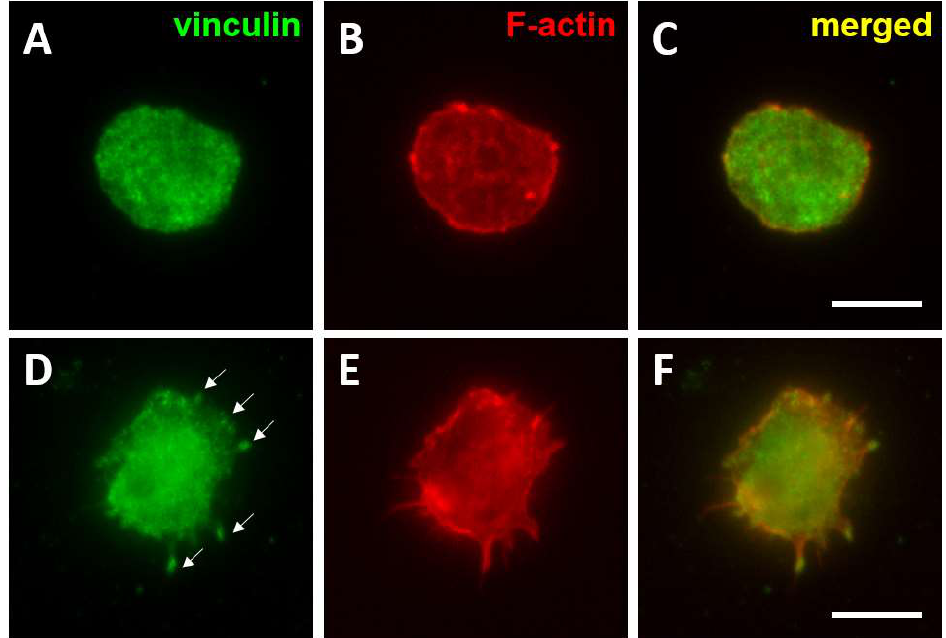
Figure 1. Formation of mature focal contacts in AML cells activated with TPA. THP-1 cells were seeded on fibronectin coated coverslips (10 µ g/mL) n and left untreated ( A – C ) or were treated with TPA (30 nM for 48 h). Cells were fixed with 4% paraformaldehyde and permeabilised with 0.05% Triton X-100 and immuno-stained to detect the distribution of vinculin ( A , D ) and F-actin ( B , E ). Merged images are shown in ( C , F ). Vinculin was quite homogenously distributed on the surface of untreated THP-1 cells, whereas TPA activation induced the clustering of vinculin into focal contacts (arrows in D ). Bar 10 m.